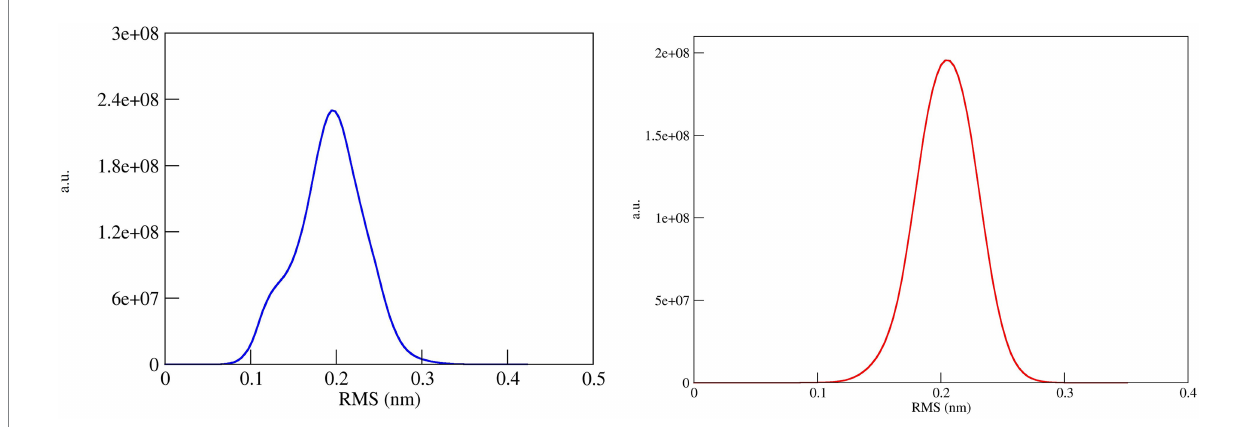
FIGURE 7 RMSD distribution plot for cluster analysis of ASP_Indie-C1 (Blue); ASP_NL4-3 (Red): Both the trajectories show a deviation of ~0.2